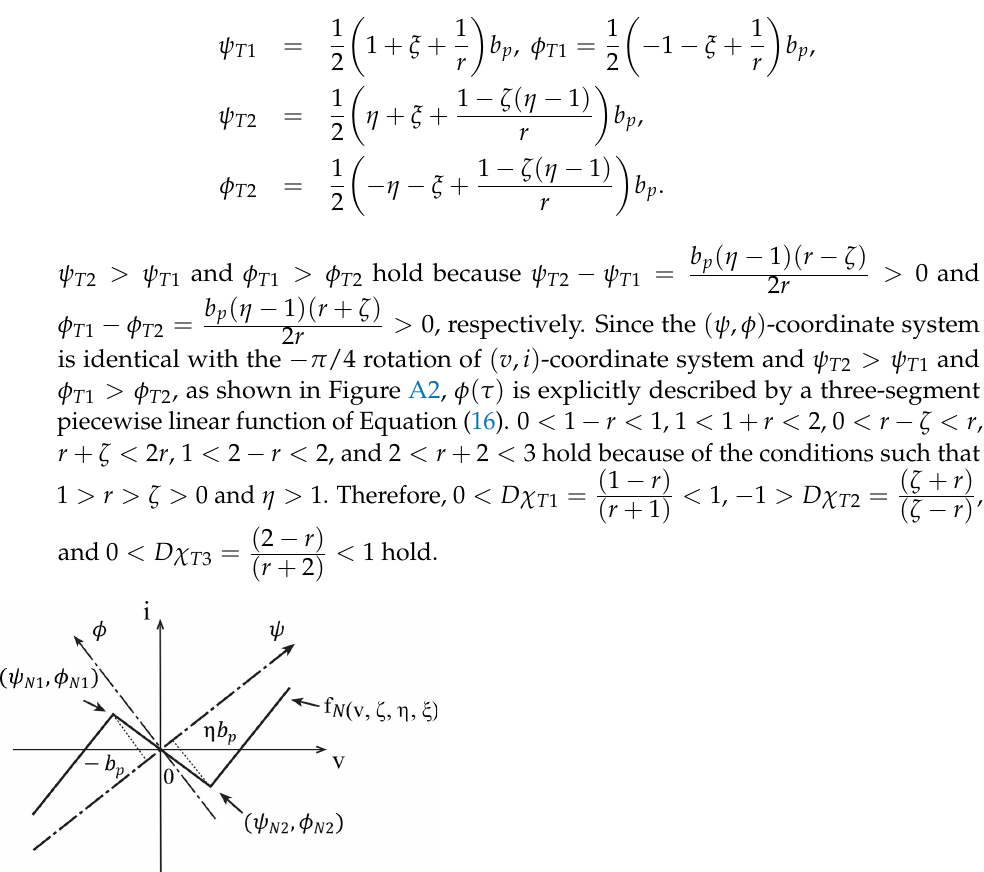
Figure A1. The characteristics of Nagumo’s 3SPWL Resistor in ( ψ , φ ) and ( v , i ) coordinate systems.